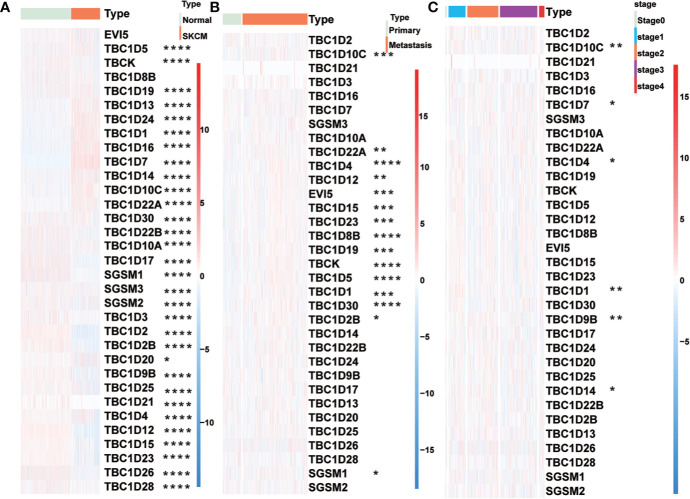
Relationship between TBCs mRNA expression and clinical features in melanoma. The heat maps based on clustering analysis according to the subgroups exhibited the differential expression patterns of TBCs (Tumor type: Normal vs Tumor (A), Tumor type: Primary vs Metastasis (B) and Tumor stage: stage0 vs stage1 vs stage2 vs stage3 vs stage4 (C). *p < 0.05, **p < 0.01, ***p < 0.001, **** < 0.0001.